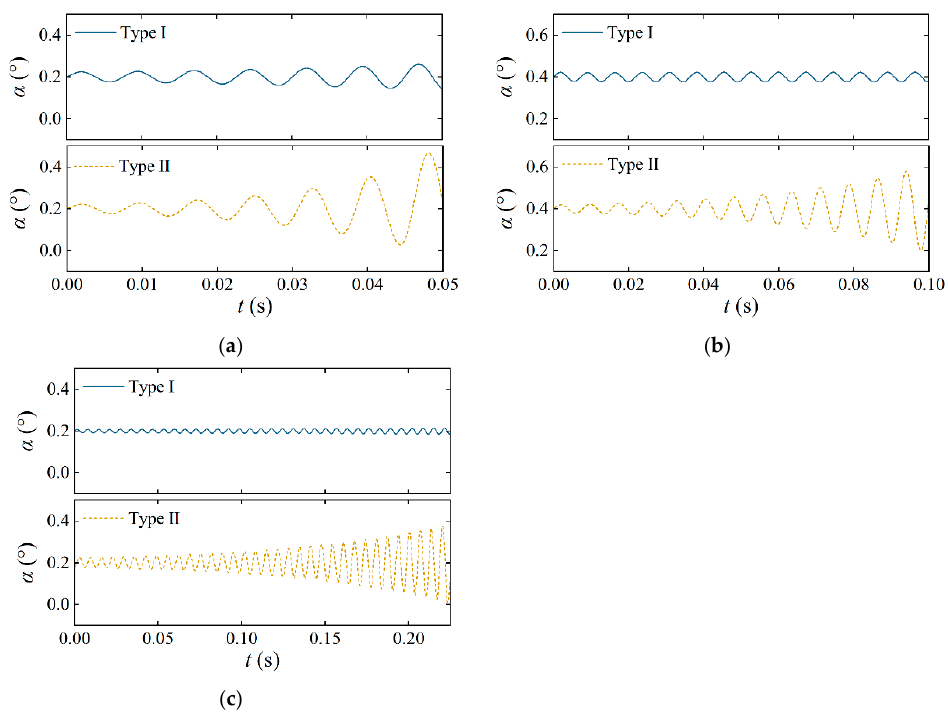
Figure 17. Time histories of GV opening angle during the vibration processes. ( a ) α = 0.2° for GV-O; ( b ) α = 0.4° for GV-O; ( c ) α = 0.2° for GV-M. Table 4. Damping ratios of GV self-excited vibration with different initial values.